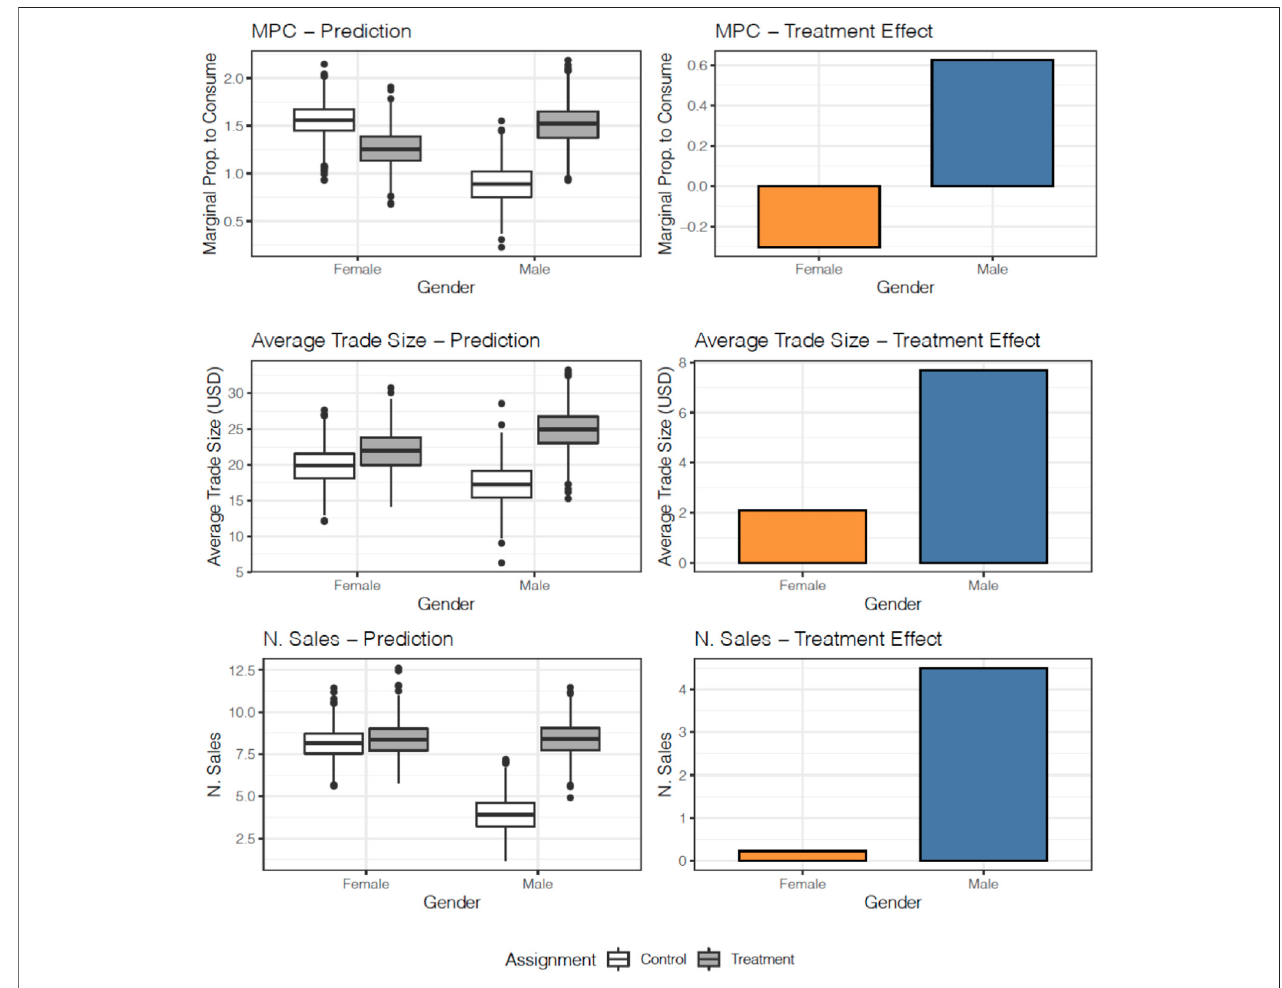
FIGURE 9 | Outcome predictions by cohort (A) and treatment effects by gender (B) .